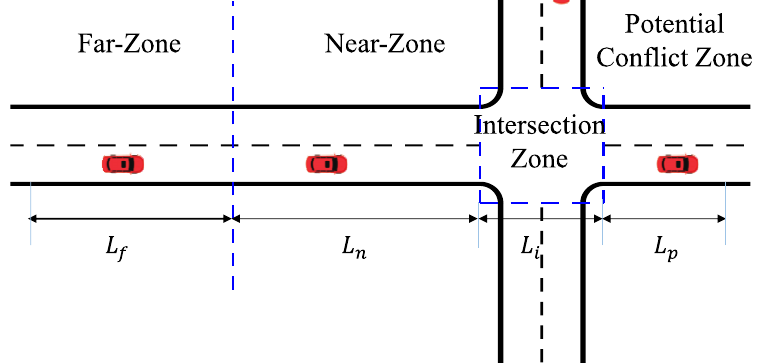
Figure 1. Intersection layout.